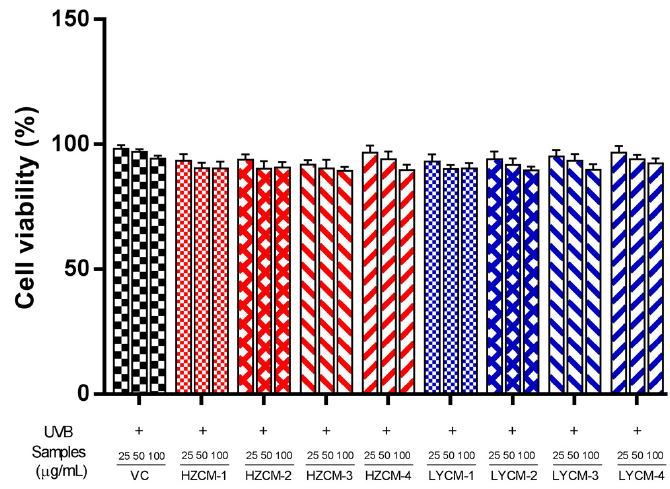
Figure 2. Effects of Cortex Moutan extracts on the viability of human dermal fibroblast. Vitamin C: VC; HZCM-1, HZCM-2, HZCM-3, and HZCM-4: Cortex Moutan (CM) collected in Heze in March, June, September and December, respectively. LYCM-1, LYCM-2, LYCM-3, and LYCM-4: CM collected in Luoyang in March, June, September, and December, respectively. Cell viability was studied at the three concentrations of VC and eight CM extracts (25, 50, and 100 µ g/mL). Data are expressed as mean ± SD ( n = 3).